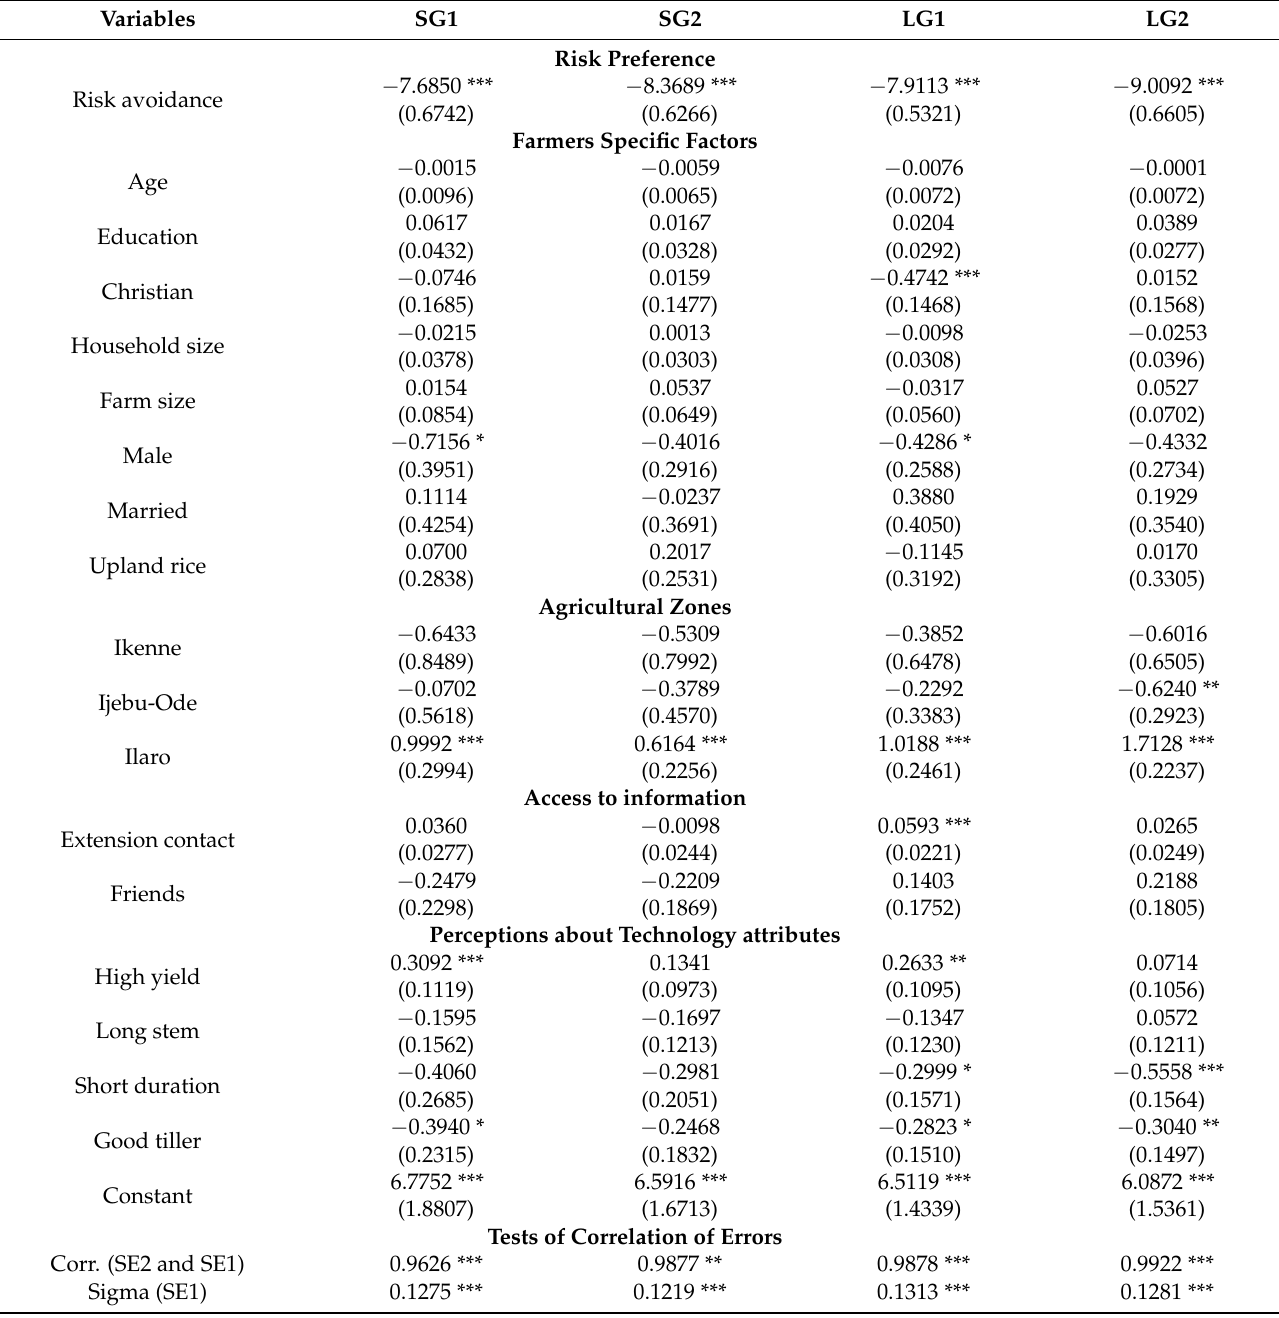
Table 2. Effect of risk preference on adoption